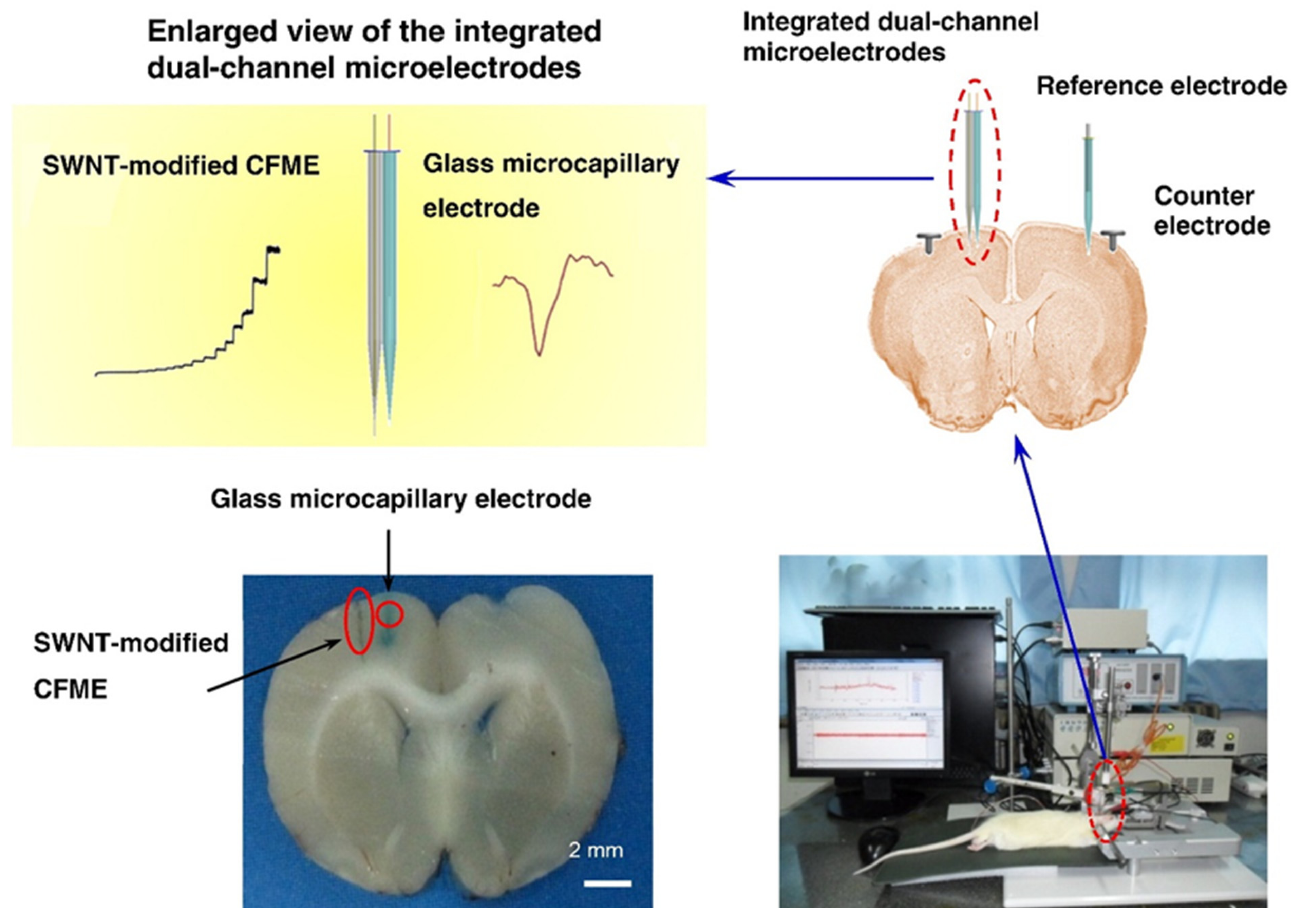
Figure 3. The schematic diagram of the experimental setup for simultaneous monitoring of AA and electrophysiological activity in vivo.